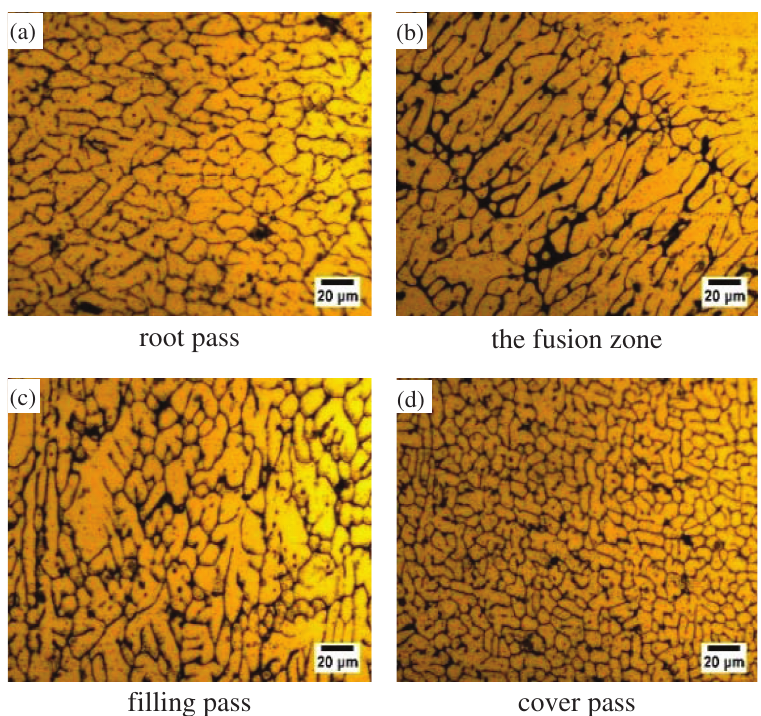
Figure 5: Microstructure of weld by